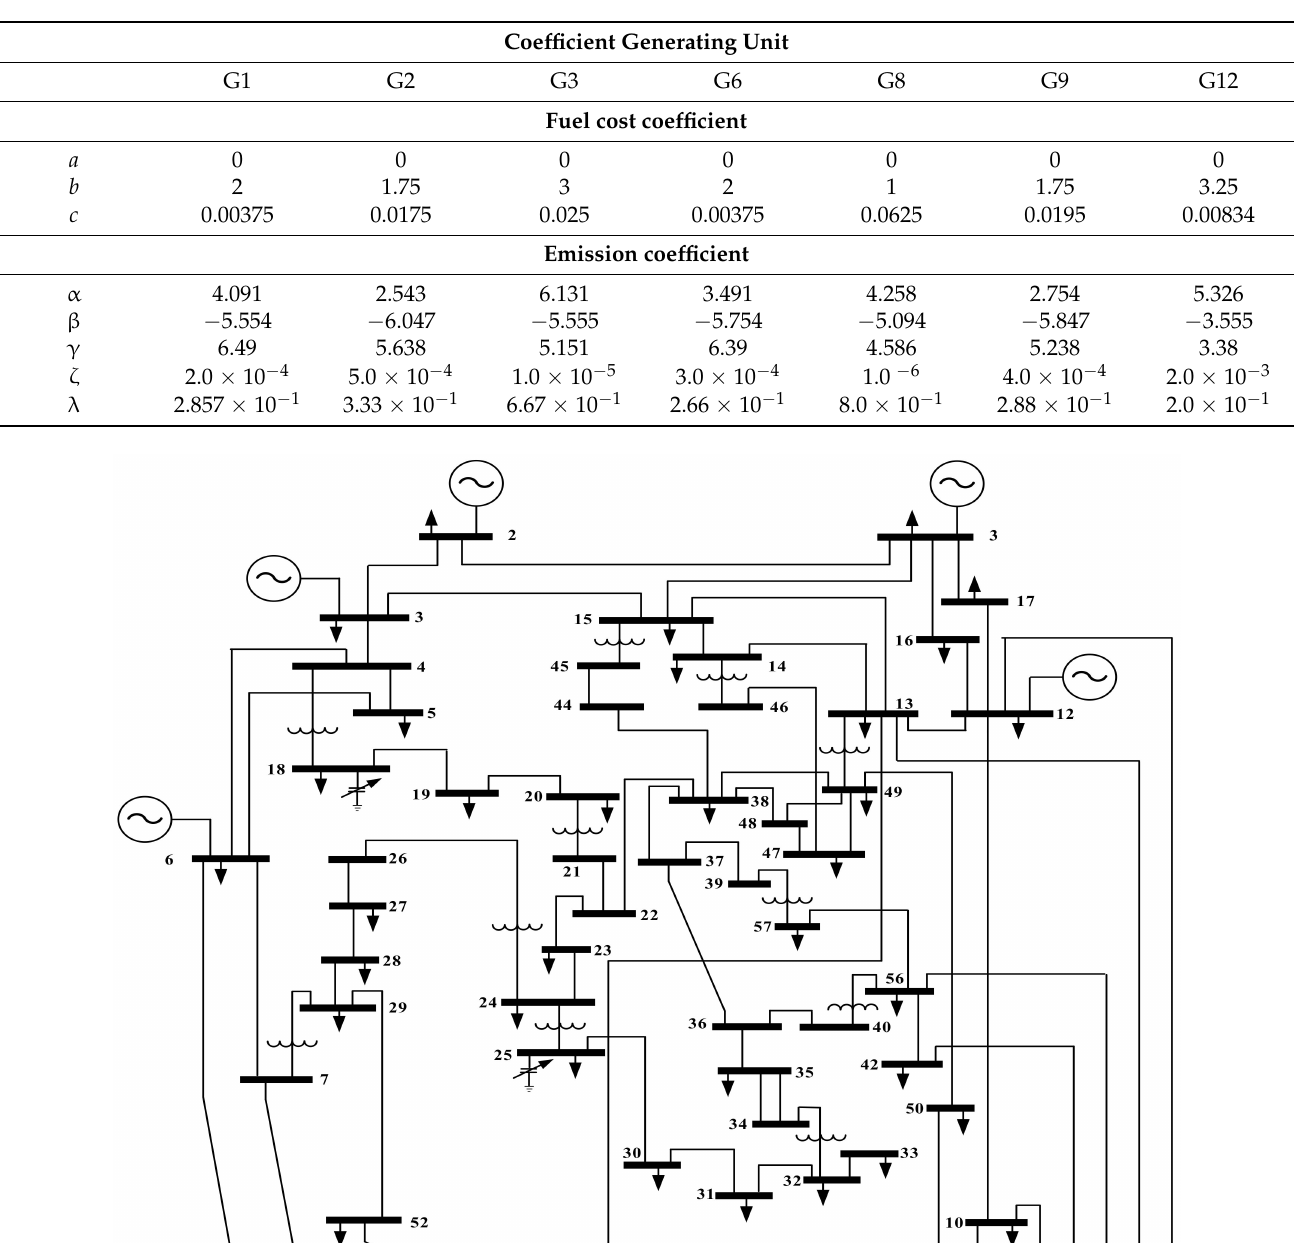
Table A2. The coefficients of cost and emission of generators for the IEEE 57-bus test system.